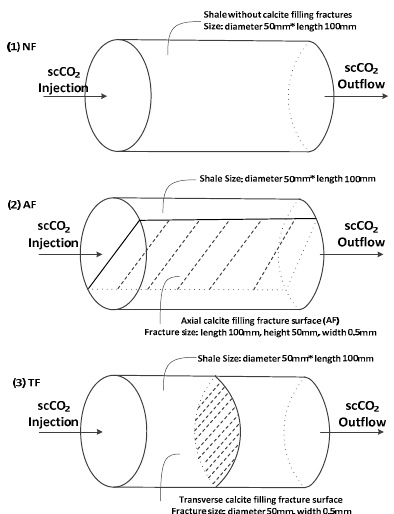
Figure 4. Conceptual diagram of shale with three different calcite filled